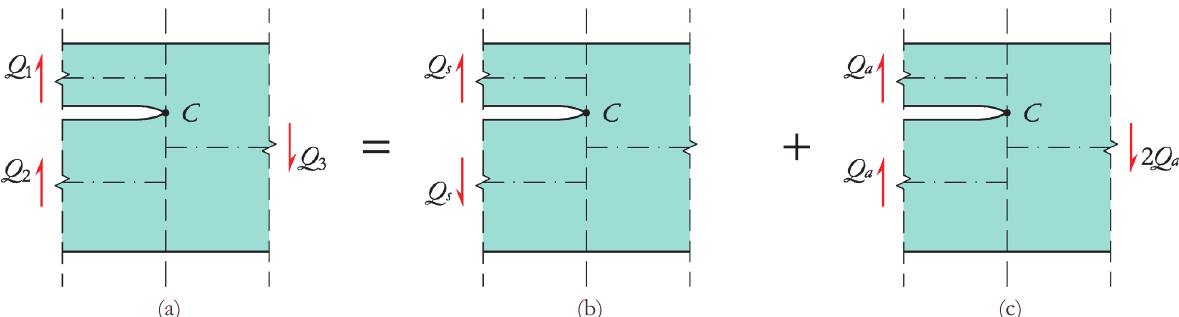
Figure 8: Decomposition of (a) the shear forces acting on a crack-tip segment into (b) symmetric and (c) antisymmetric systems.